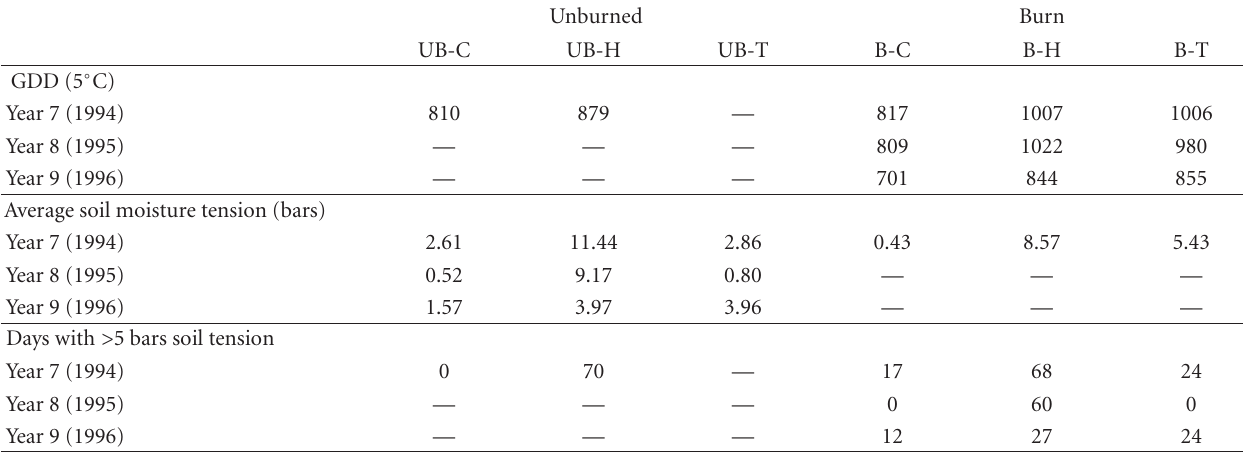
1 Refer to Table 1 for treatment